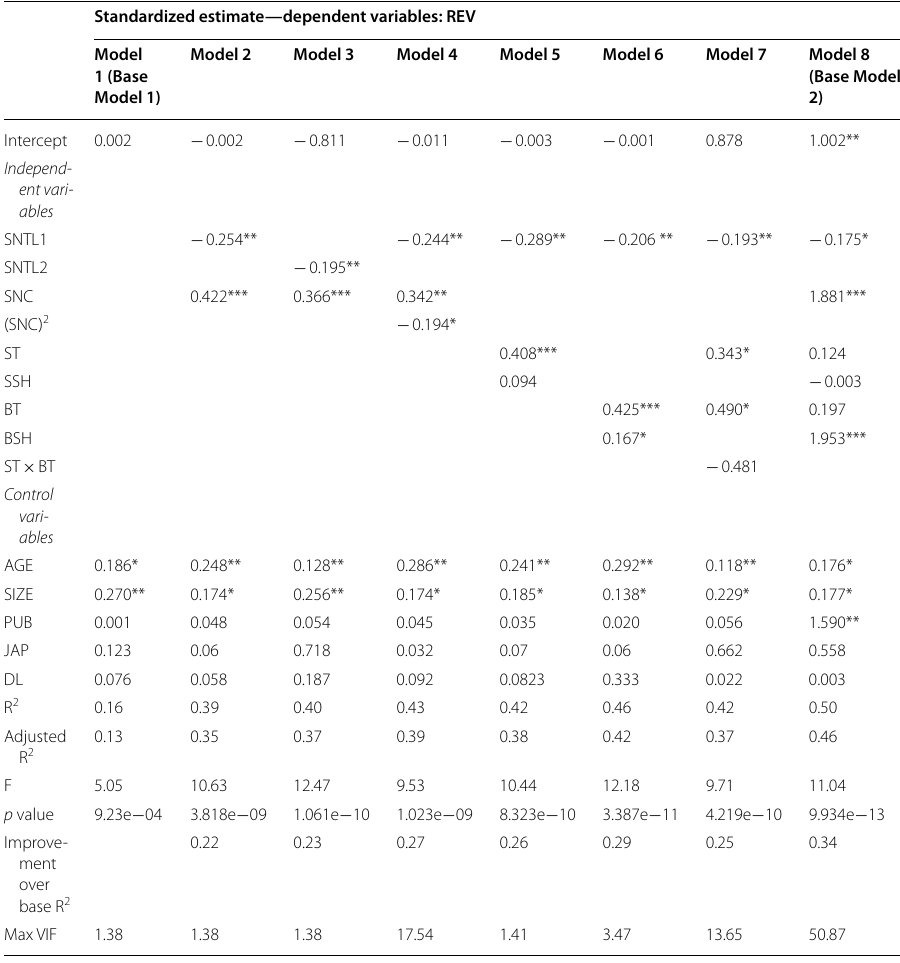
Table 4 GLS Regression results—total annual